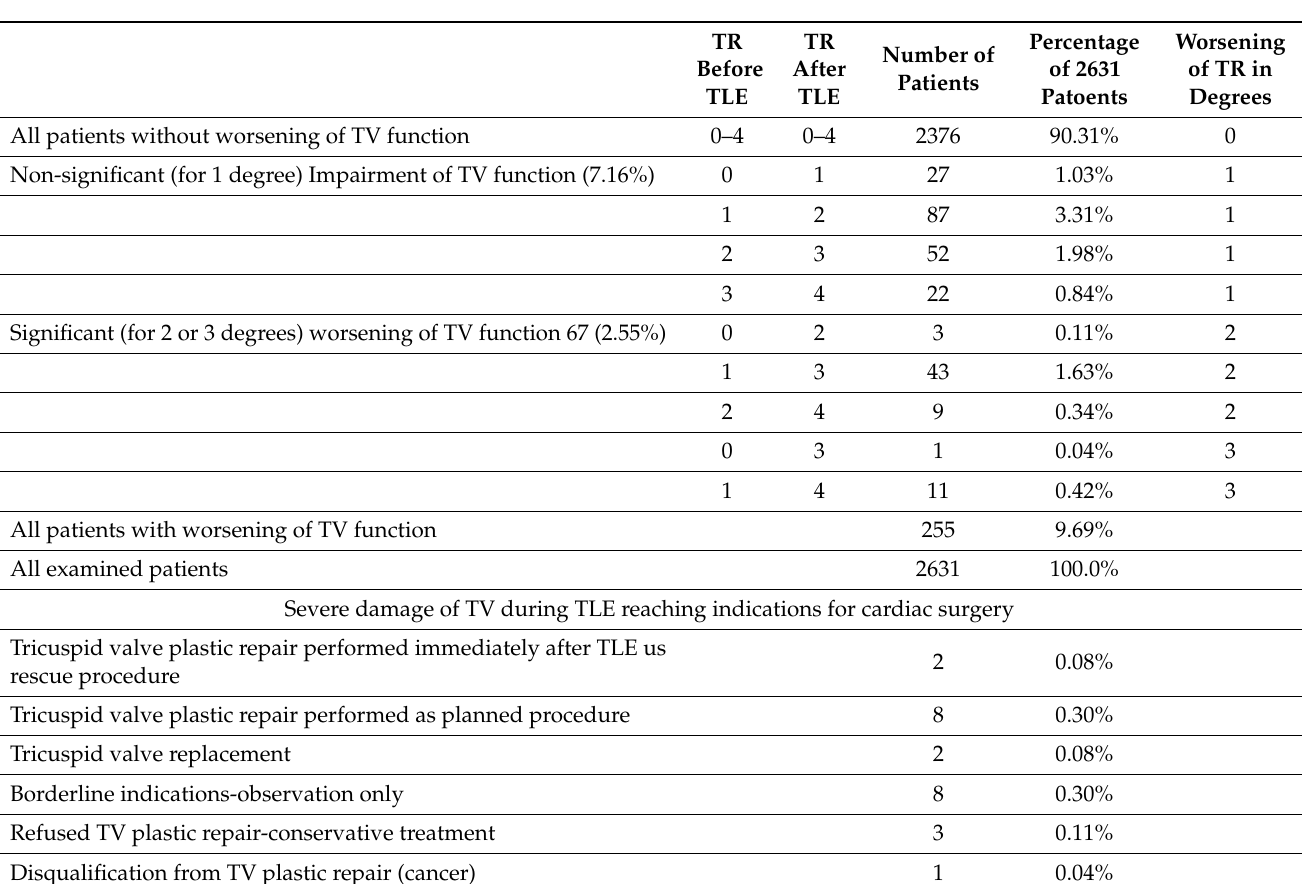
Table 1. Analysis of changes in the degree of tricuspid regurgitation after transvenous lead